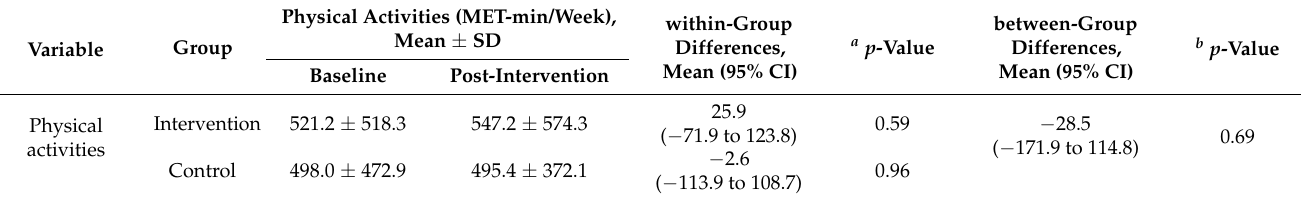
Table 2. Physical activities at baseline and